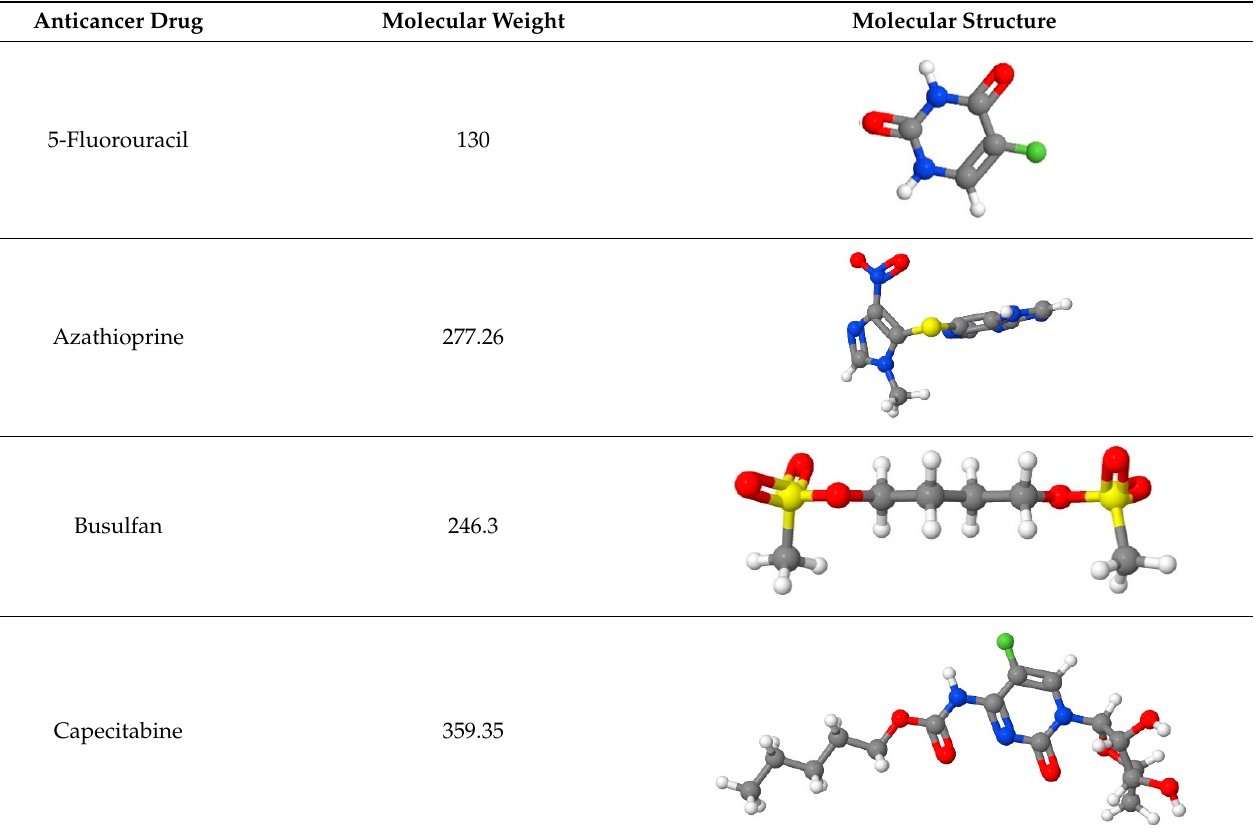
Table 2. Molecular weights and chemical structures of the investigated anticancer drugs.